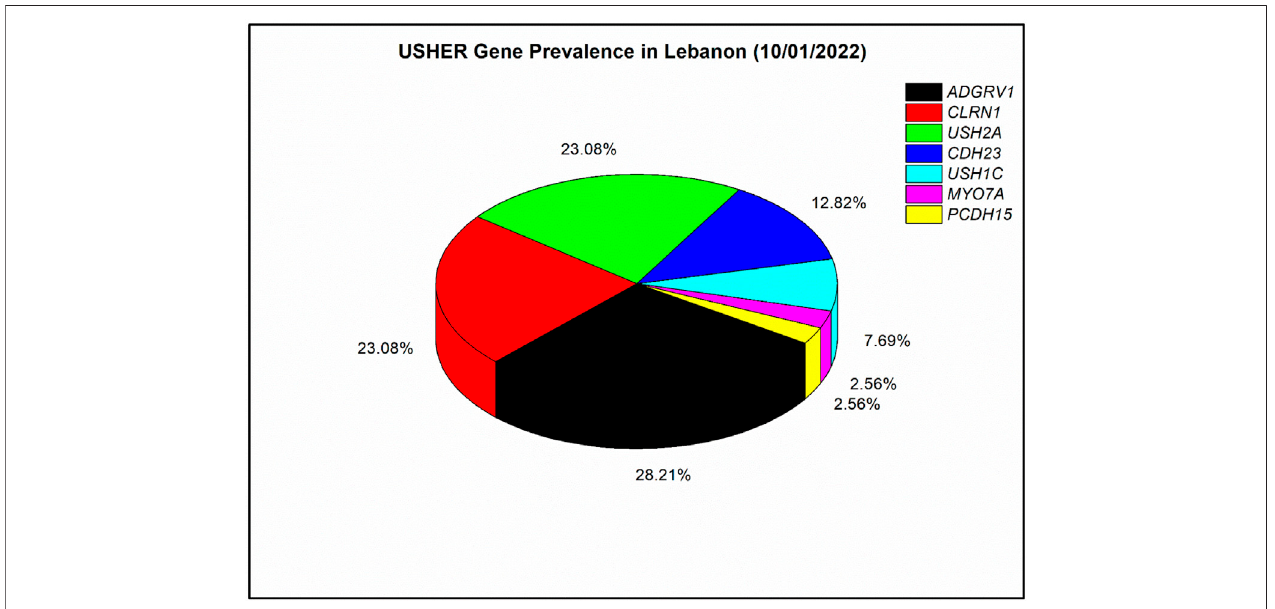
FIGURE 2 | Prevalence of mutated Usher genes detected in the Lebanese population to date (till 10/01/2022). A meta-analysis with four previously published articles wasdone (Verpyet al.,2000; Akoury et al., 2011;Reddyet al.,2014; Jaffal et al., 2019); intotal, 39 affected individualswith Ushersyndromewere included. The prevalence analysis is based on the number of affected individuals and not families as in Reddy et al.